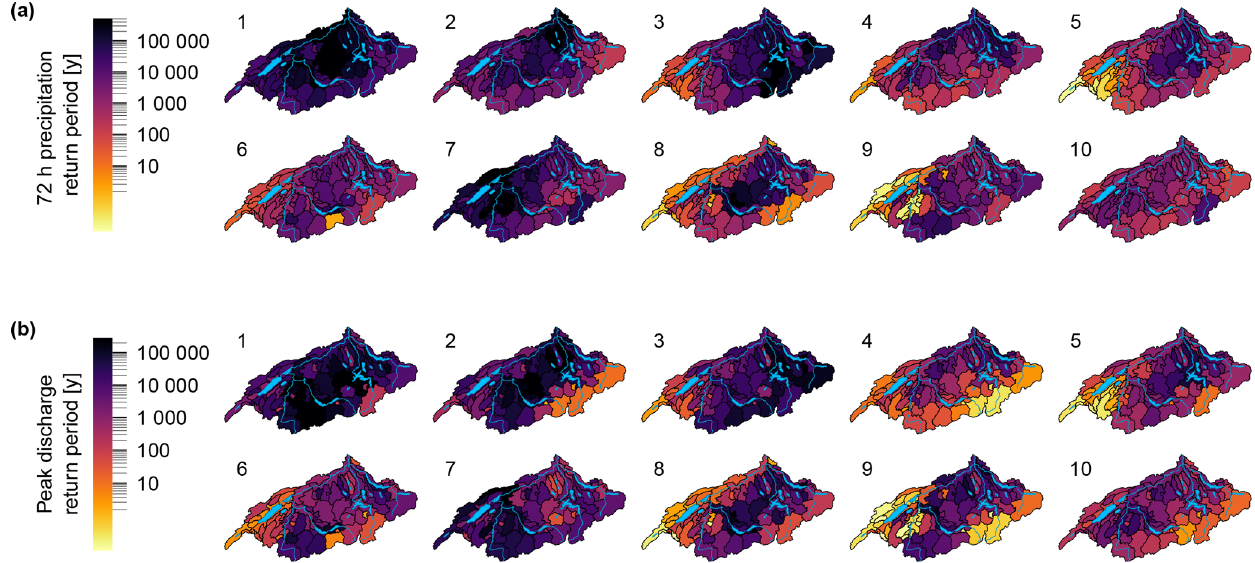
Figure 11. Patterns of return periods for cumulative precipitation (maximum 72h sum, using Gringorten plotting position) (a) and specific peak discharge (using Weibull plotting position) (b) for the 10 largest peak flow events simulated at the outlet of the Aare River basin. For absolute values, see Fig.